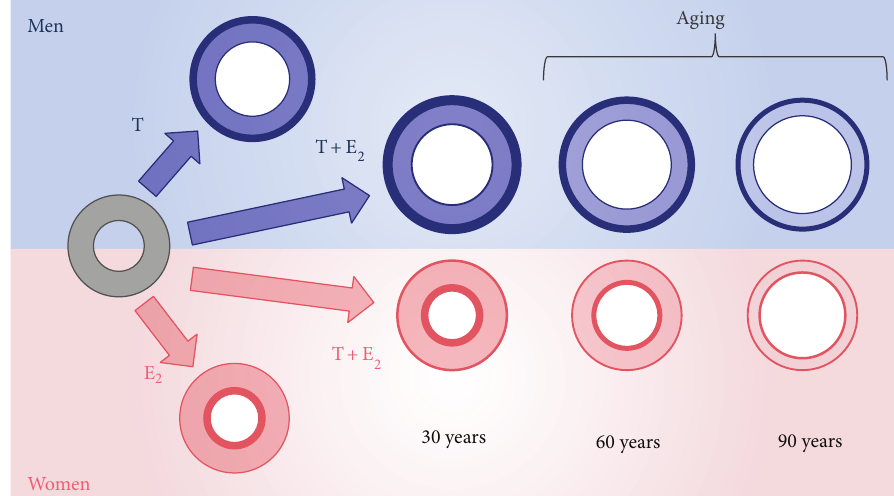
Figure 3: Schematic representation of the role of estrogen and androgen bone size according to gender. The effects of sex steroids on cortical and trabecular bone are represented. Bone size is reached in late puberty and early adulthood as depicted at the left of the panel where the effect of each sex steroid and their sum are shown according to gender. In men, the combined action of both T and E 2 led to greater bone size and cortical thickness than in women. The prevailing effect of E 2 is consistent with higher endosteal bone formation in women. Bone loss during aging occurs in a different fashion between man and women and is subordinate to the baseline conditions. Women lose more bone on the endosteal surface and in the trabecular portion of bone, while men lose mainly bone mass in the cortical bone (right side of the panel). E 2 : estradiol, T: testosterone; modified in part from figures published in [75,